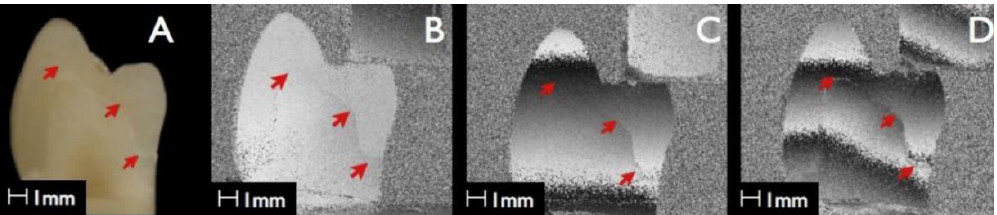
Figure 9. Prosthetic crown sample ( A ) under white light, ( B ) under a force of 36.78 N, ( C ) under a force of 77.56 N and ( D ) under a force of 64.09 N. Comparative mechanical behaviour of dentin enamel and dentin ceramic junctions assessed by speckle interferometry (SI). Adapted with permission from Ref. [103]. 2019, Elsevier.